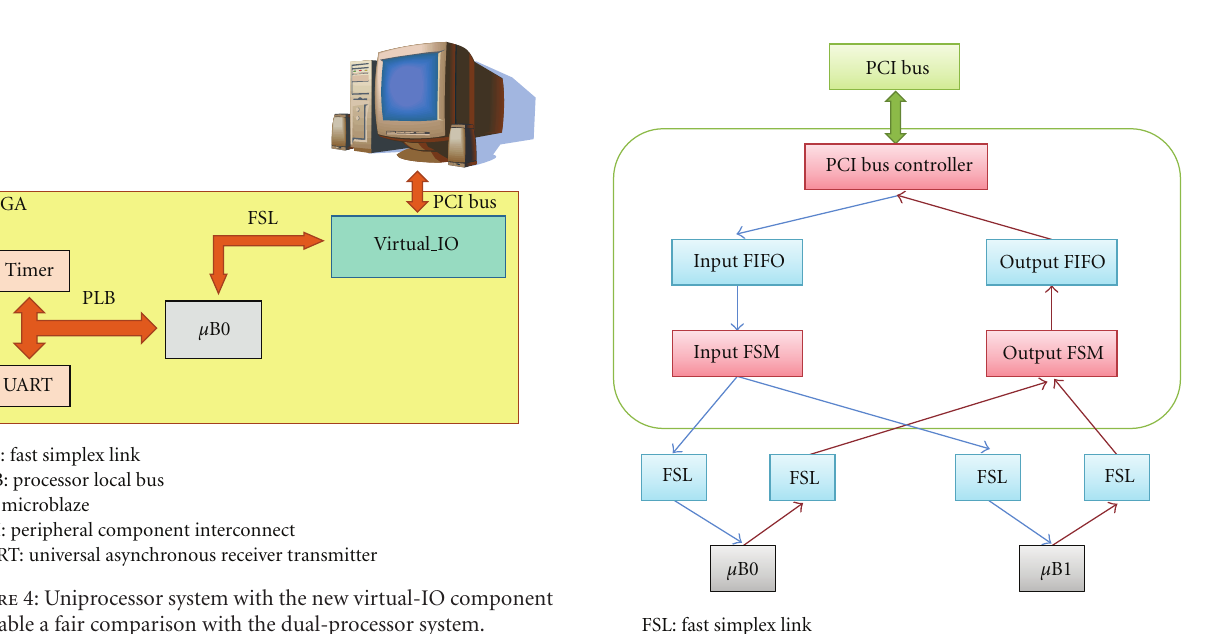
Figure 3: Dual-processor design with three new components: virtual-IO, bridge, and reconfigurable clock unit.